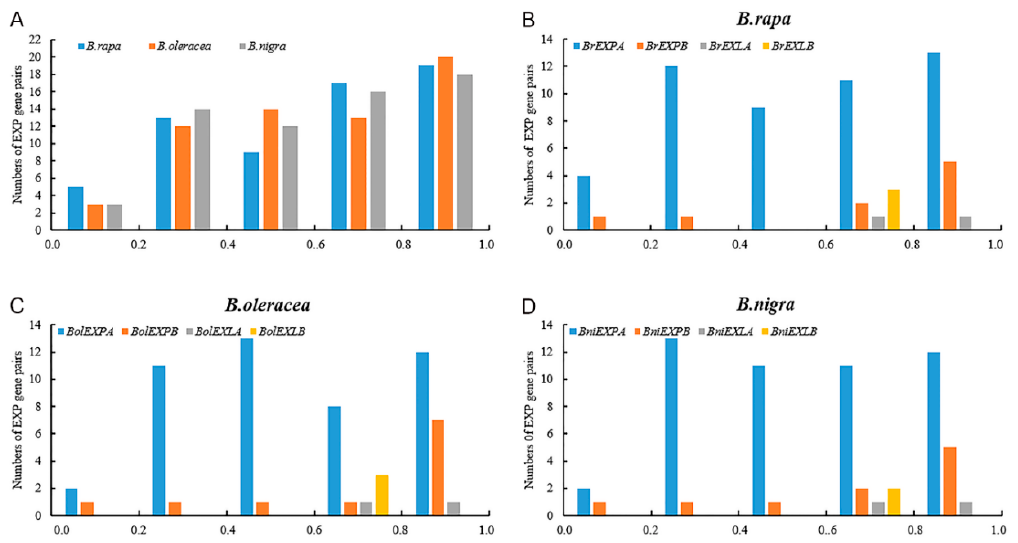
Figure 8. The d SM distributions of orthologous expansin gene pairs between A. thaliana and B. rapa , A. thaliana and B. oleracea , and A. thaliana and B. nigra . ( A ) The d SM distribution in the three basic species of Brassica . ( B – D ) The d SM distribution in the four subfamilies of B. rapa , B. oleracea , and B. nigra .